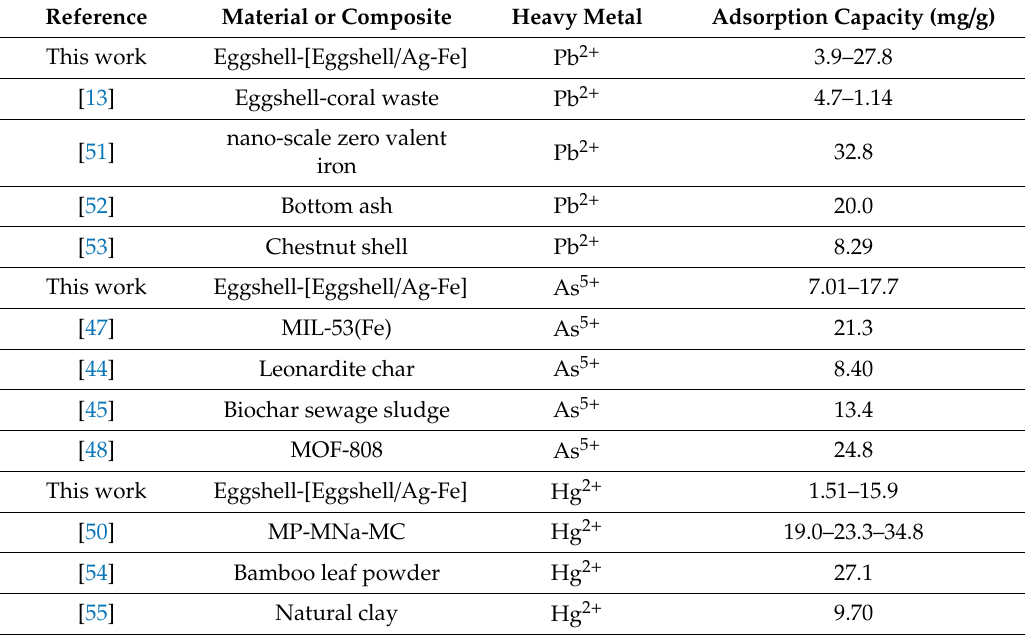
Table 3. Adsorption capacity of various materials for the removal of lead, mercury, and